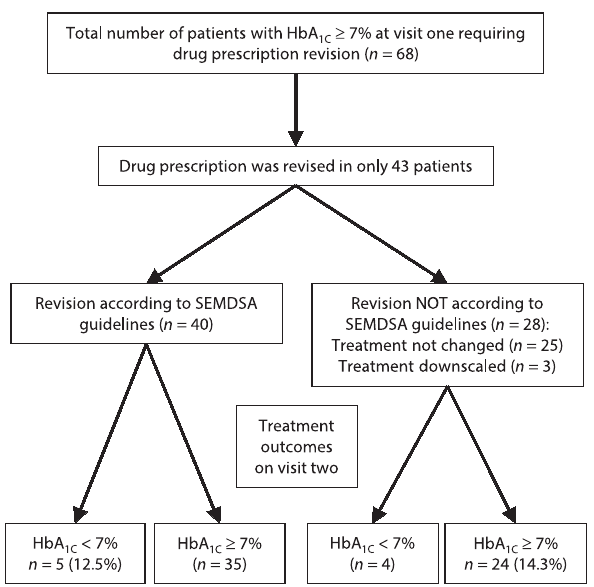
Figure 2: Flow diagram showing patient outcomes following two different prescriptions (according to and not according to 2009 SEMDSA guidelines and not using those prescribed by SEMDSA).